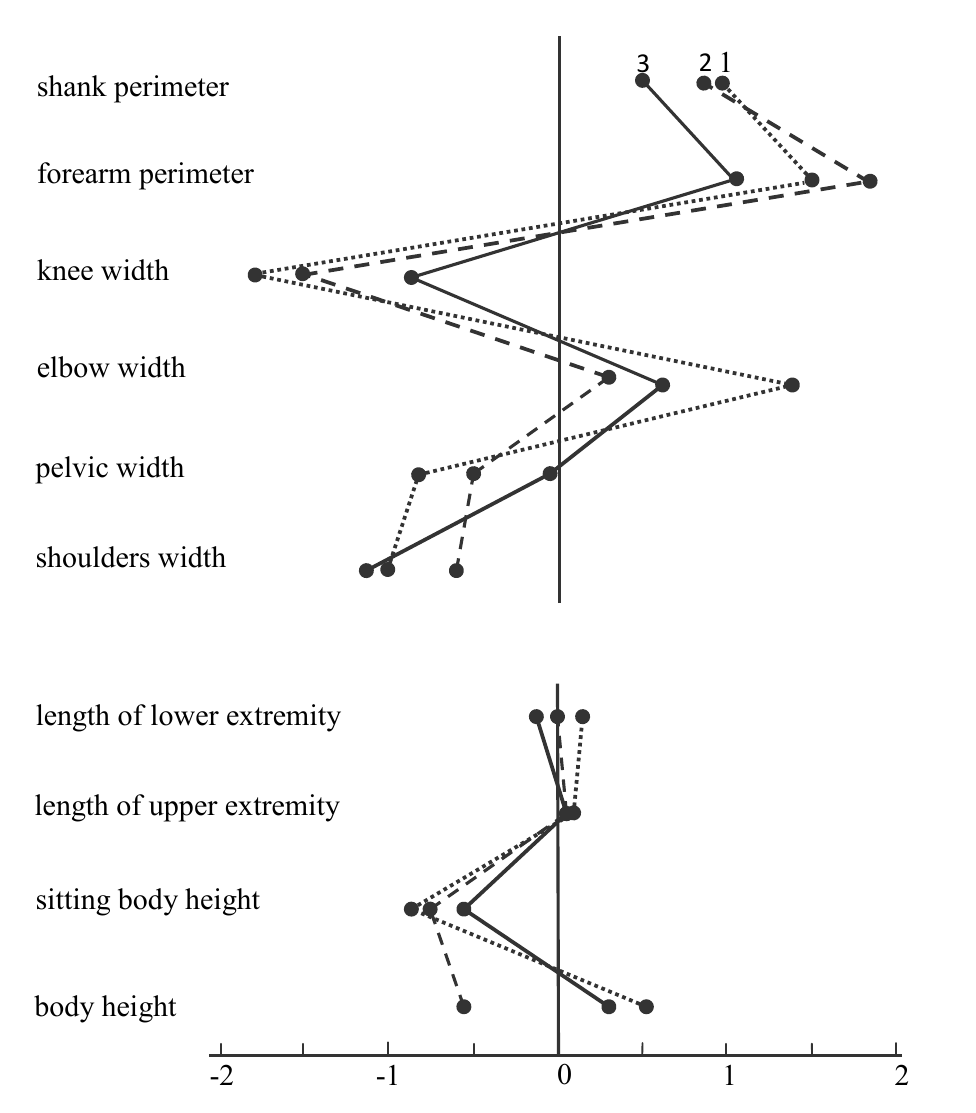
Figure. 2. Natural indicators of somatic features within factors of the body composition among baseball players, n